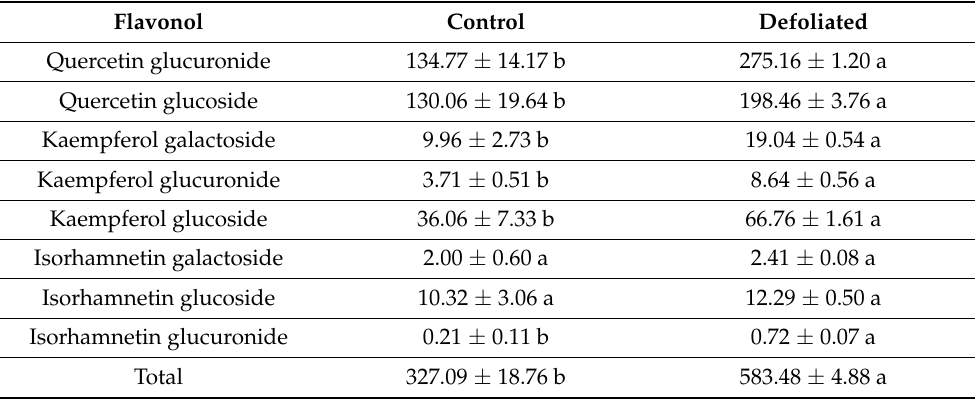
Table 3. Favonols ( µ g/g − 1 fresh weight) in grape berries from control and defoliated vines of Vitis vinifera (Trebbiano variety). Data are reported as mean values ± standard error. For each compound means accompanied by different letters are significantly different at p ≤